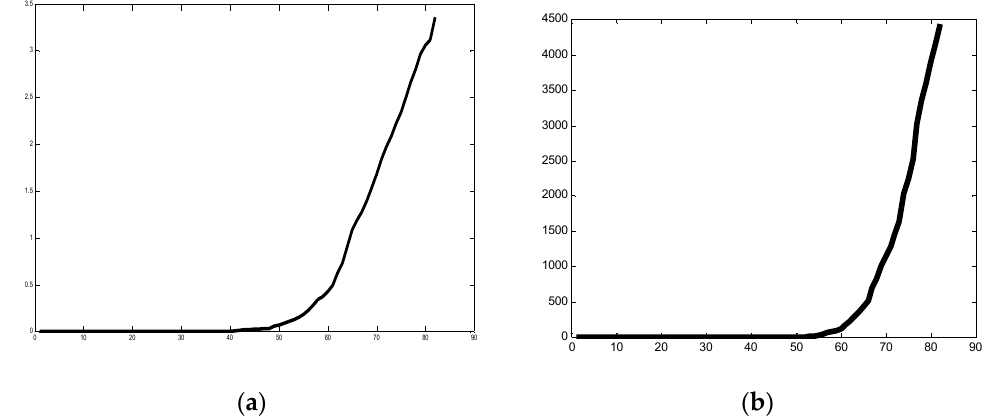
Figure 7. ( a ) Plot of confirmed cases for Belgium, ( b ) plot of death cases for Belgium (2 January 2020 to 31 March